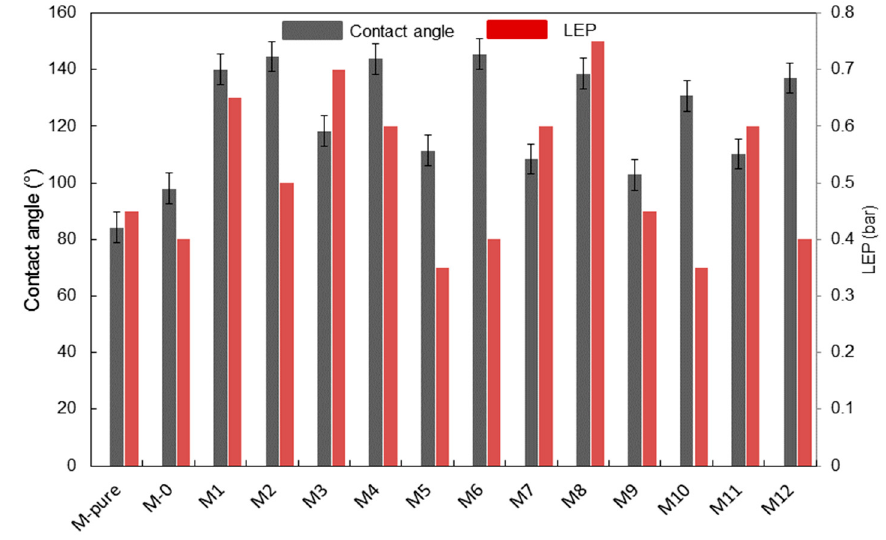
Figure 5. Contact angle of synthesized membranes.